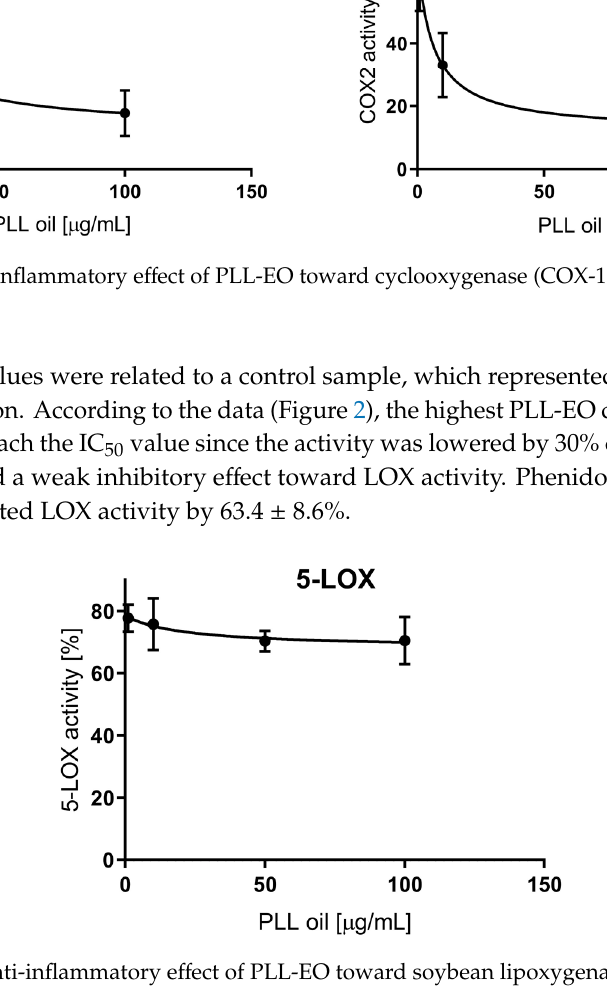
Figure 3. Cyclic voltammetry of PLL-EO with a scanned potential range (E app ) between -200 mV and +800 mV vs Ag/AgCl reference electrode, in the absence (black line) and in the presence of 200 mg/mL PLL-EO (red line), in comparison with 1 mM α - tocopherol (green line). 2.4. Viability Assay The protective effects of PLL EO toward the oxidative stress affecting the GF were evaluated by the MTT assay, testing different concentrations of the oil. The results showed a significant increase in cell viability when GFs were treated with 10, 25, 50 and 75 µg/mL of PLL EO in comparison to that observed in the control group and using the DMSO 0.1%. Differently, the cells subjected to the